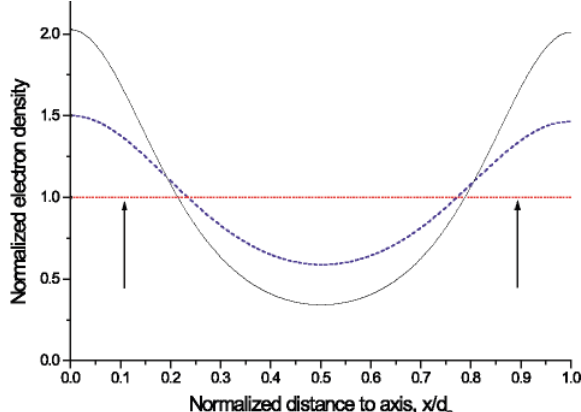
FIG. 3. (Color) The (cid:5) 100 (cid:6) axial electron density in diamond along the (100) (dashed line) and (110) (solid line) planes, cal- culated from Lindhard’s “standard” model [3], normalized to the average value shown as a dotted line. The region accessible to a particle with u (cid:1) c 1 (cid:2) 2 is between the